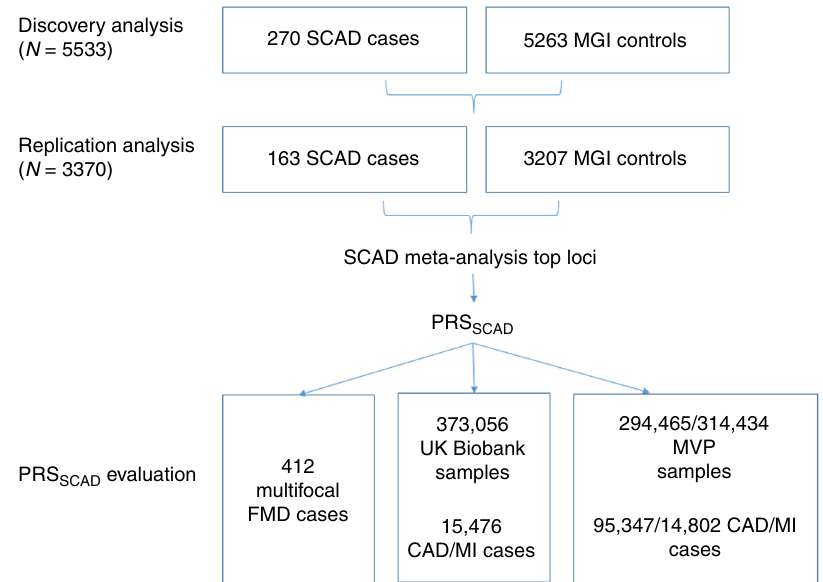
Fig. 1 Discovery study design for the SCAD genome-wide association analysis (GWAS) and PRS SCAD development and testing. In both the discovery and replication phases, CanSCAD study samples were analyzed with control subjects derived from the MGI biorepository with electronic health record- based phenotyping to exclude individuals with vascular diseases or connective tissue disorders. The association of genetic variants with SCAD and MI was tested by means of a PRS developed with the top ranked loci in the GWAS meta-analysis of SCAD discovery and replication analyses (PRS SCAD ). The PRS SCAD was tested for association with SCAD and MI in a cohort of individuals with FMD and for CAD and MI in the UK Biobank and